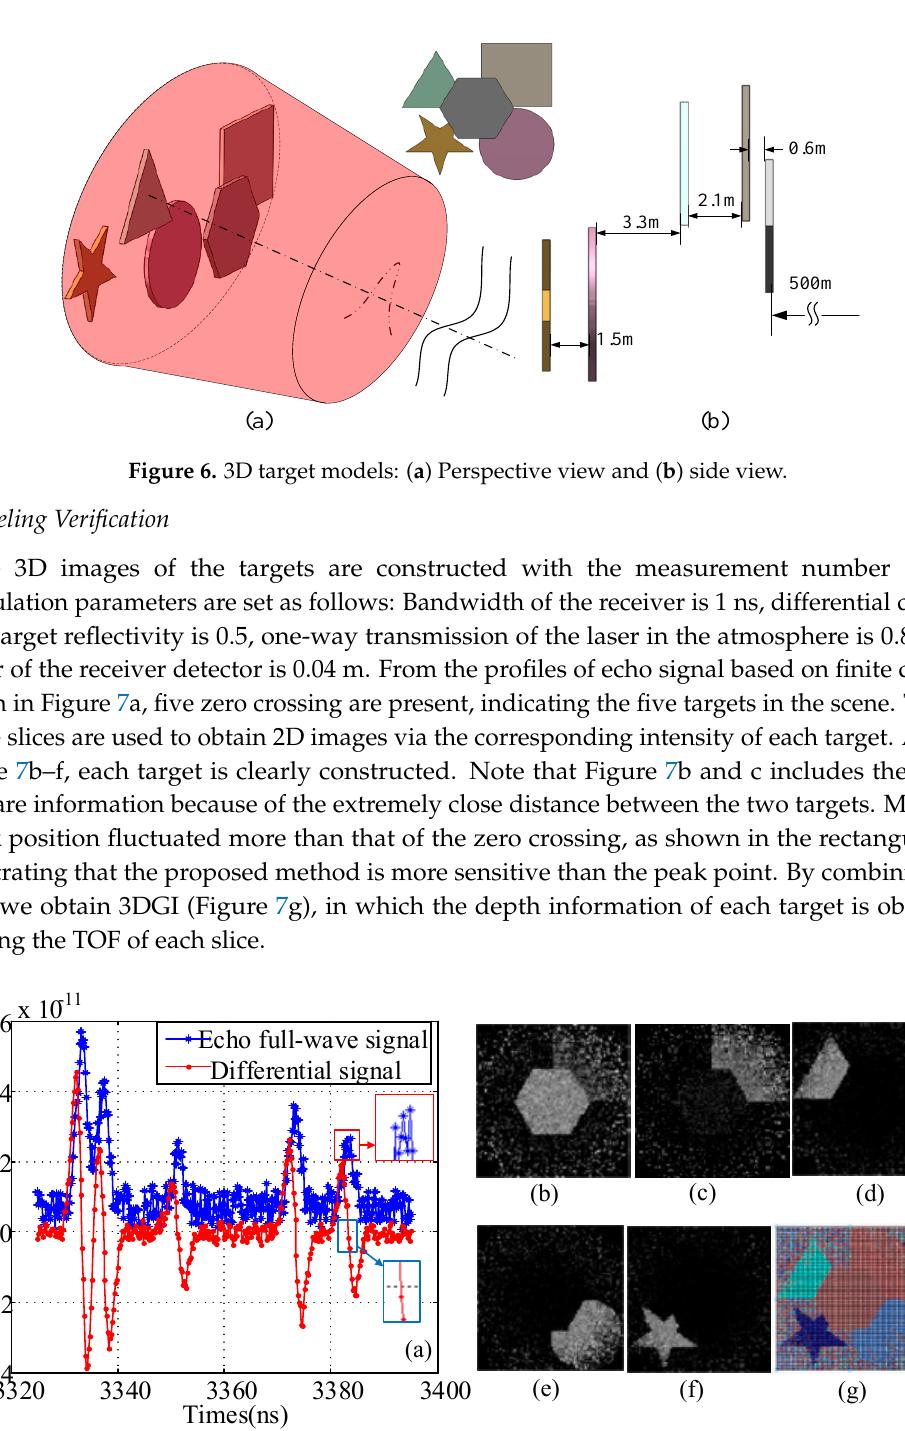
Figure 7. Results of echo signal based on finite difference, 2D, and 3DGI: ( a ) Echo signals based on a single detector and finite difference, ( b )–( f ) 2D images under different distances (500–508 m), and ( g ) 3DGI obtained by combining 2DGI. All the above results are without any post-processing .